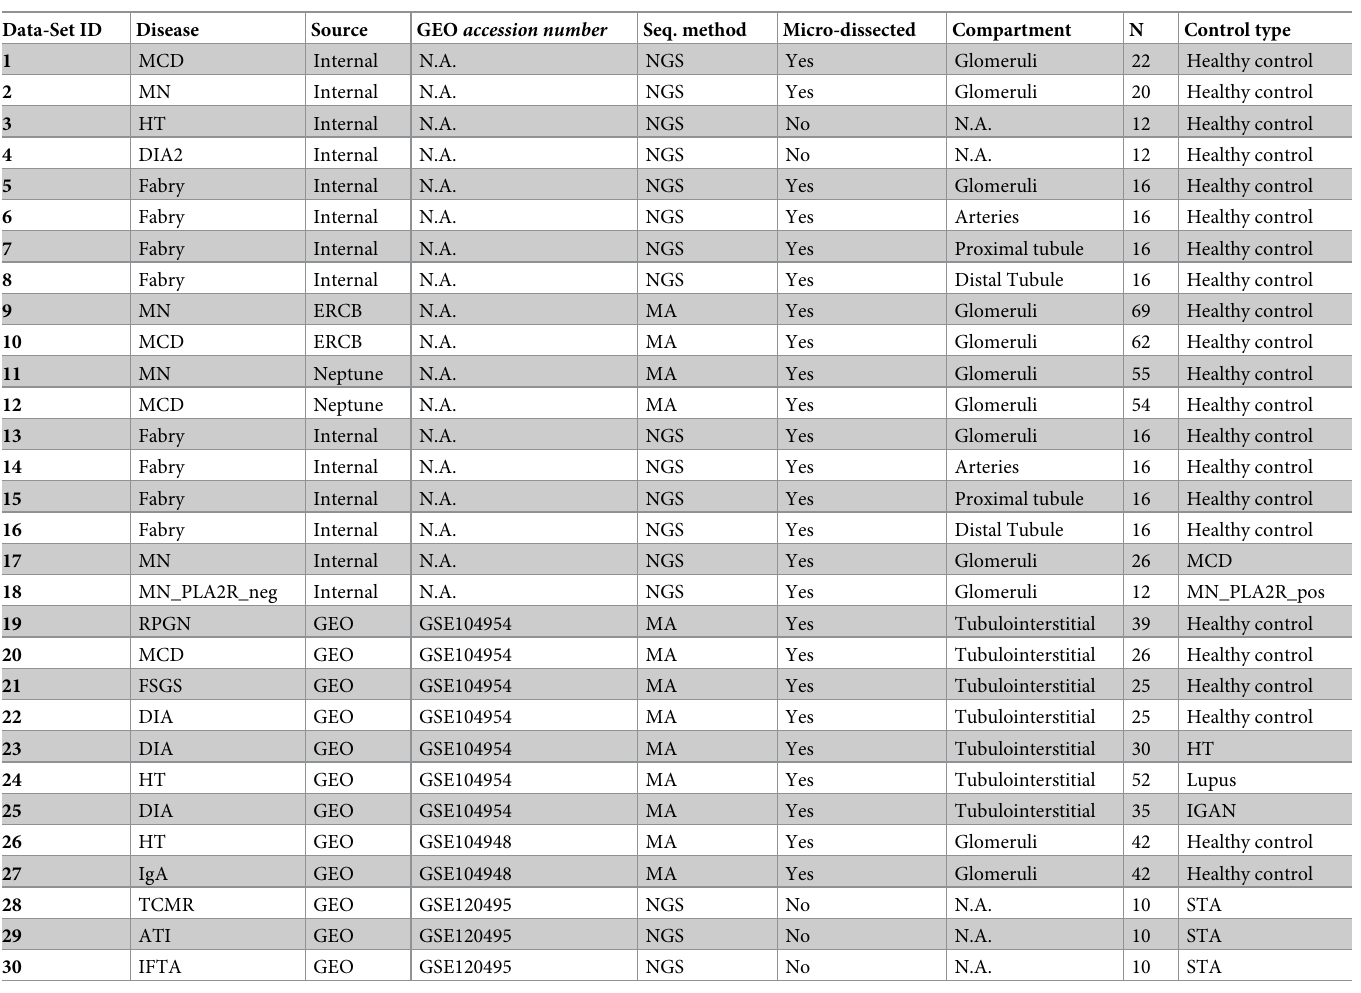
Table 1. Dataset